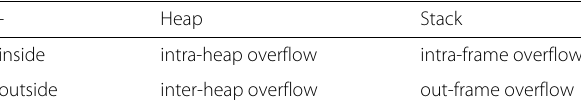
Table 2 Four types of pointer overflow error according